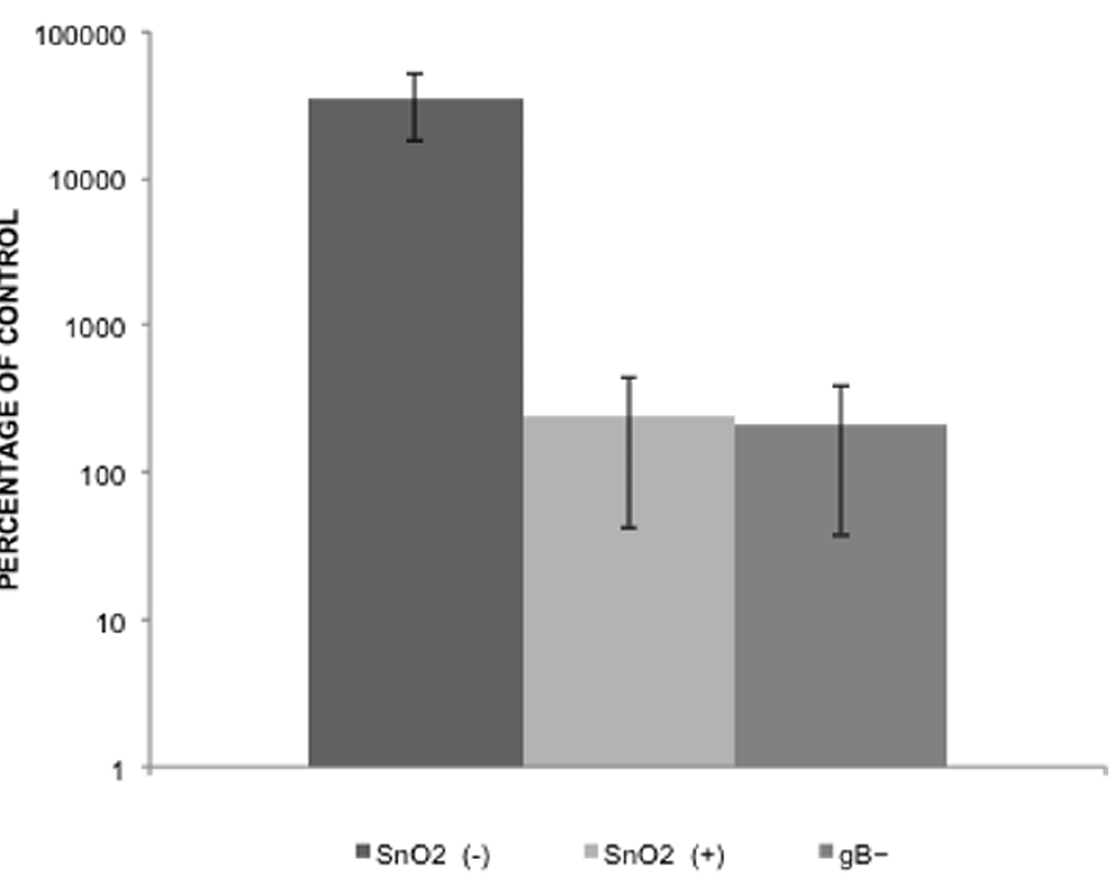
Figure 5. SnO 2 treatment reduces glycoprotein mediated cell-to-cell fusion. Two populations of cells were generated to determine the effect of SnO 2 treatment on cell fusion. Effector cells were transfected with plasmids gB, gD, gH, gL and T7. Target cells were transfected with gD, receptor Nectin-1 and a luciferase expressing plasmid under the control of a T7 promoter. Target and Effector cells were mixed together at a 1:1 ratio. Luciferase activity was determined in the presence of firefly luciferase, allowing the measurement of relative light units (RLU). CHO-K1 cells were either mock treated or treated with SnO 2 . As a negative control, effector cells lacking gB were mixed with the target cells.